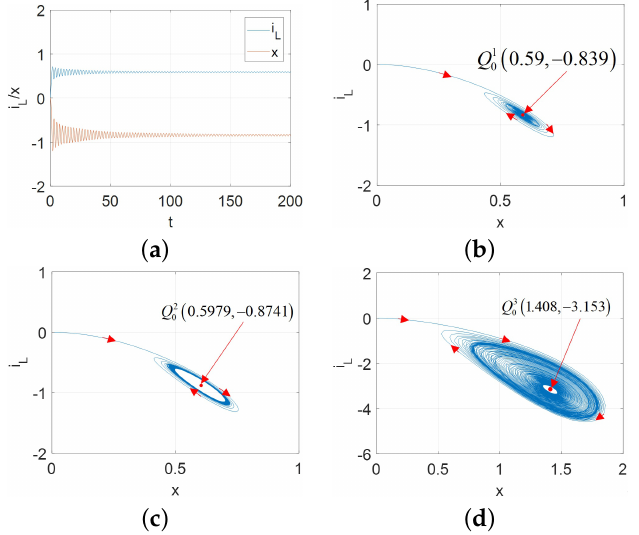
Figure 17. The supercritical Hopf bifurcation over the range v (cid:101) [ − 2.4, − 1.6 ] and initial condition [ x ( 0 ) , i ( 0 )] = [ 0.01,0 ] for A = A ( t ) and i ( t ) for v = − 2.41 V; ( b ) stable limit cycle converges L M : ( a ) x L to Q 1 (0.59, –0.839) for v = − 2.41; ( c ) stable limit cycle corresponding to the periodic waveforms for 0 v = − 2.39; ( d ) stable limit cycle converges to Q 3 (1.408, –3.153) for v = − 1.5906. 0